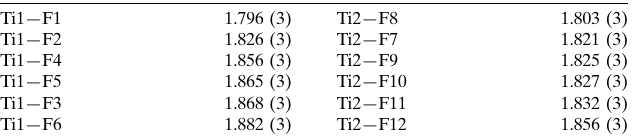
Selected bond lengths (A˚ ).